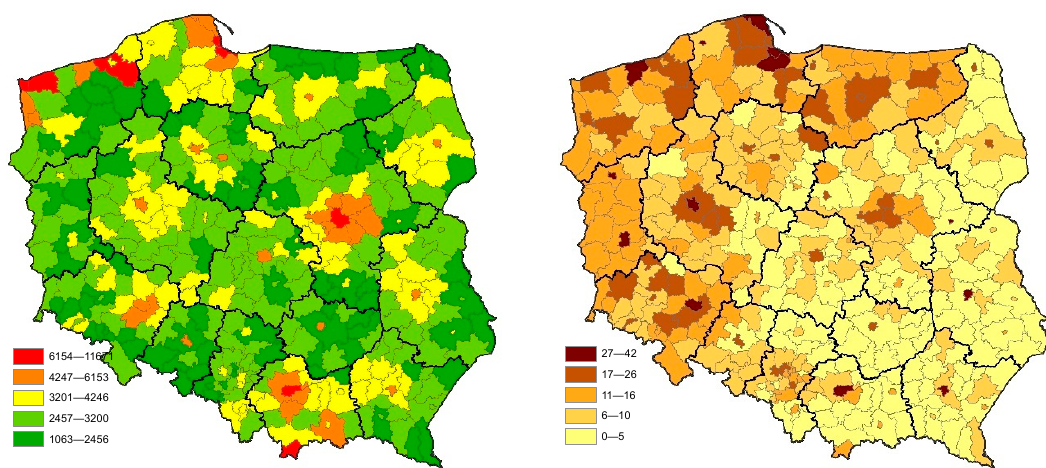
Figure 1. Average price of 1 m 2 and number of flats sold in 2018 in each county in Poland. Source: own research based on GUS (Central Statistical Office) data.